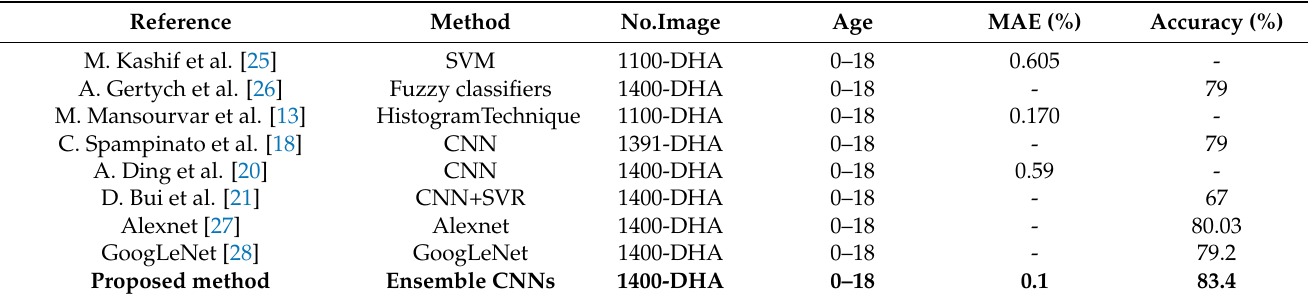
Table 6. Comparison of the methods implemented on the DHA